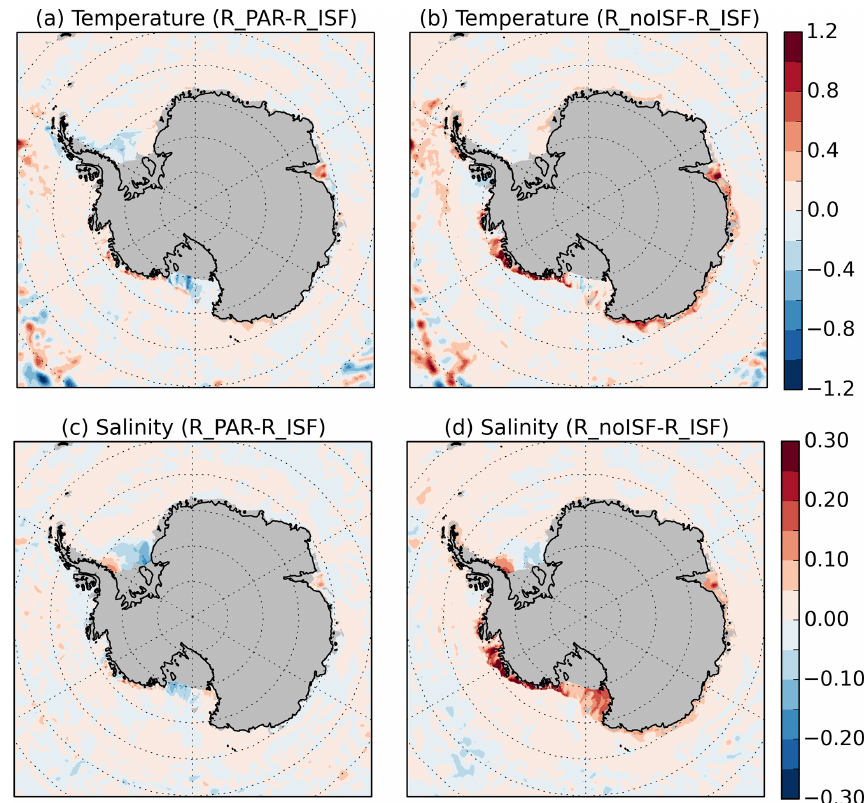
Figure 12. Map of temperature in ◦ C (a, b) and salinity in PSU (c, d) differences between R_PAR and R_ISF (a, c) and R_noISF and R_ISF (b, d) averaged between 300 and